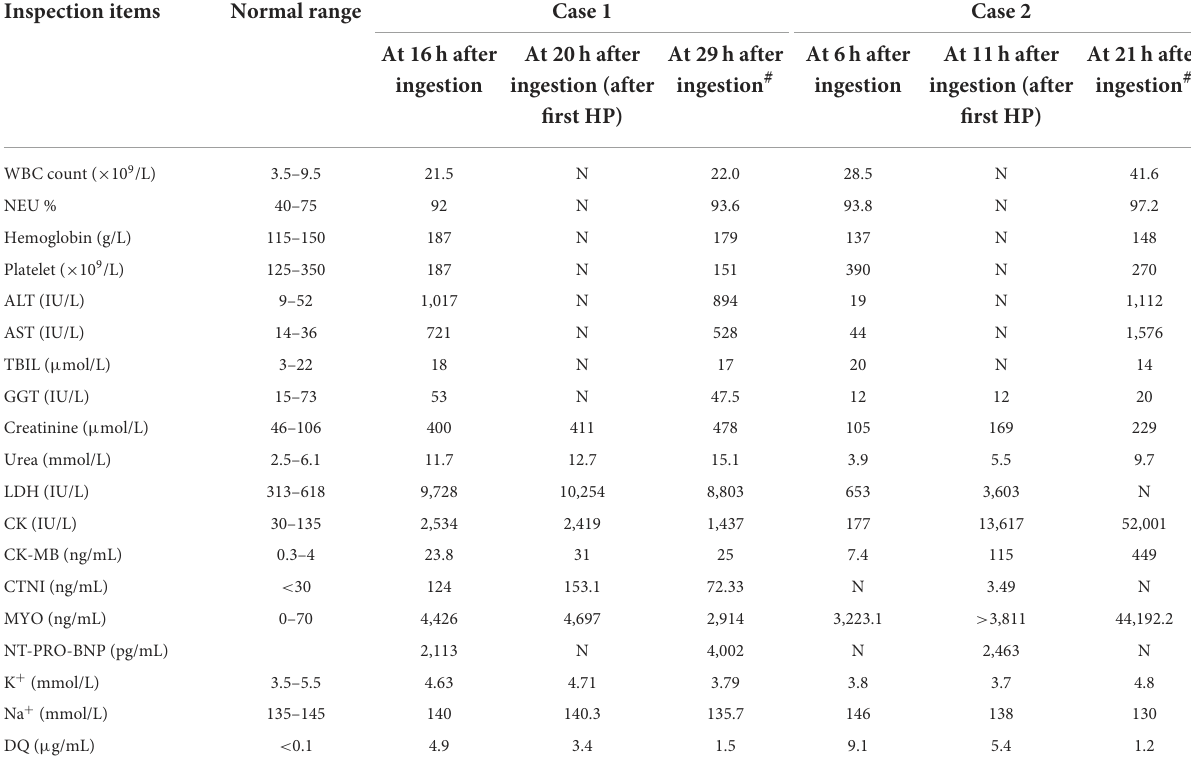
TABLE 1 Patients’ laboratory test